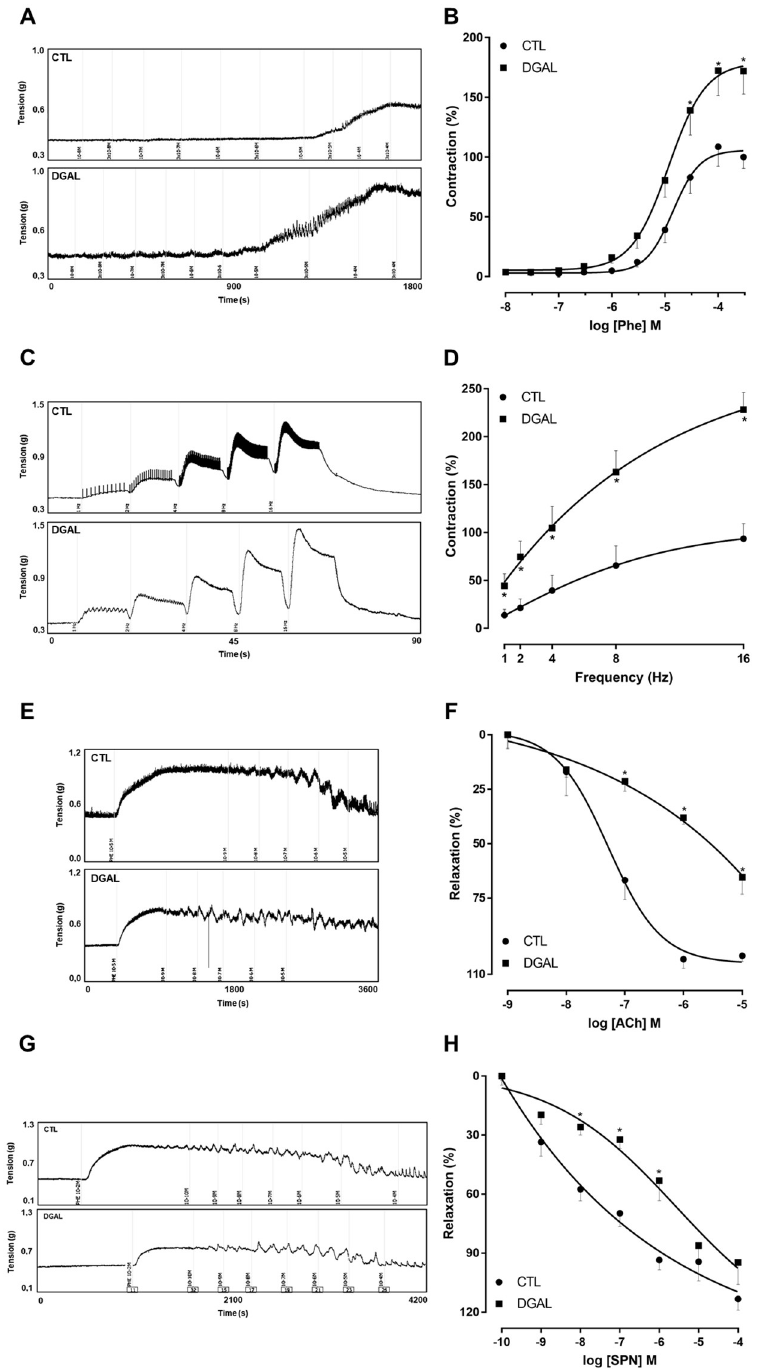
Fig 3. Representative traces (A) and concentration-response curves (B) for Phe; representative traces (C) and frequency-response curves (D) for the electrical field stimulation EFS; representative traces (E) and concentration-response curves (F) for ACh; representative traces (G) and concentration-response curves (H) for SNP; in the corpus cavernosum isolated from rats at eight weeks of treatment, for both the CTL ( ● ) and DGAL ( & ) groups. Groups: CTL (vehicle); DGAL (D-(+)-galactose 150 mg/Kg). The results are expressed as mean ± SEM. The data were analyzed using the two-way ANOVA statistical test, followed by the Bonferroni post-test. � p < 0.05 vs